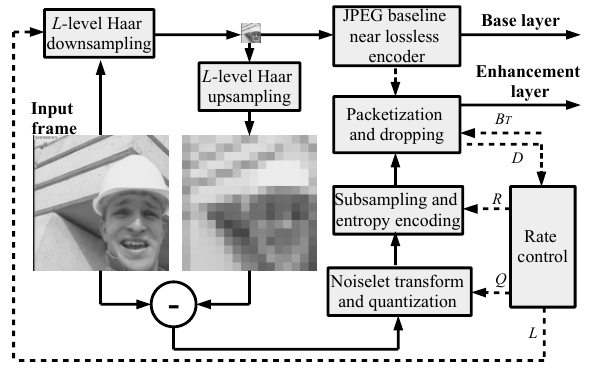
Figure 1. CS-JPEG intra-frame